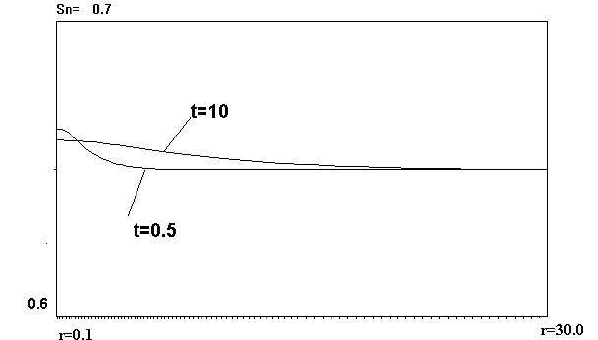
Figure 4: Oil saturation distribution